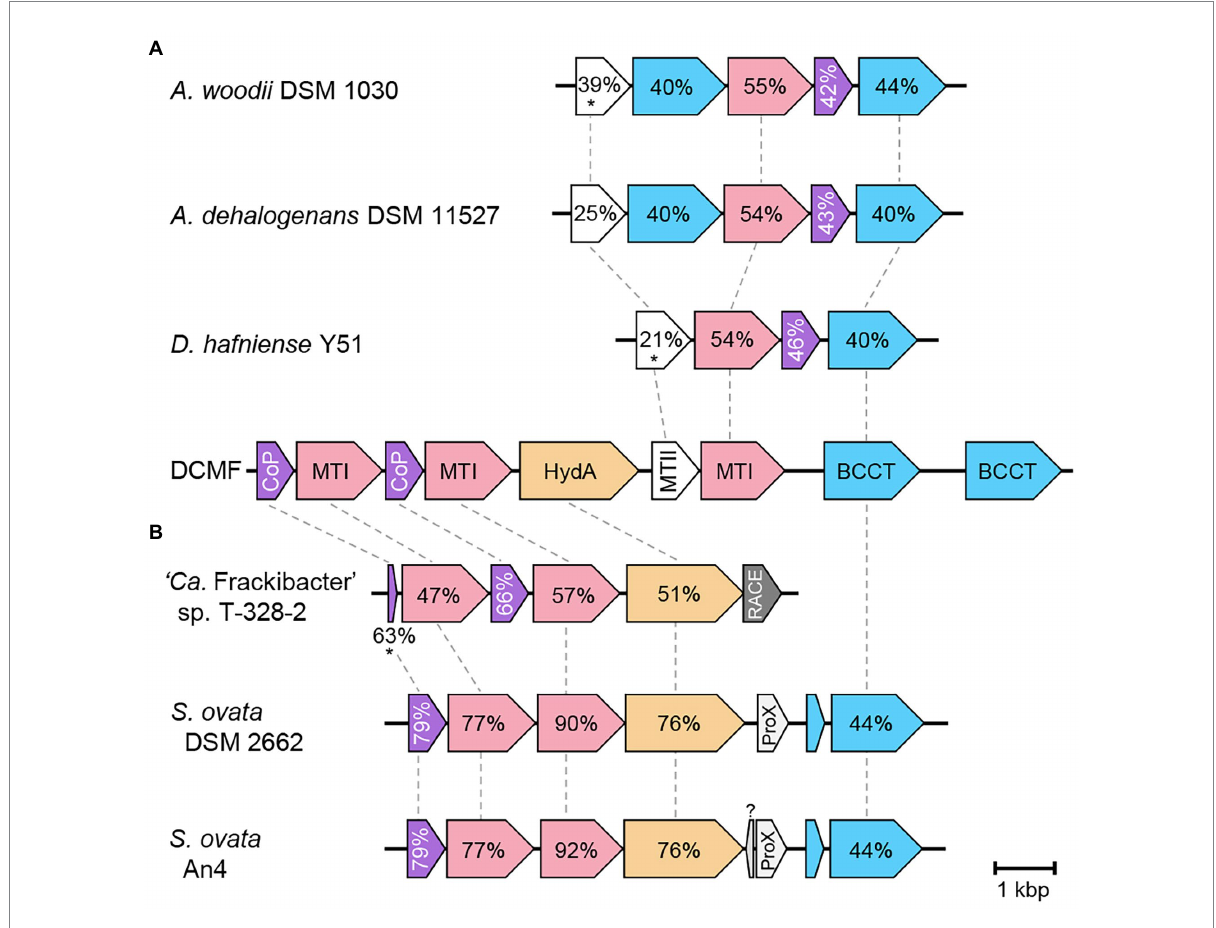
FIGURE 5 Genetic organization of the glycine betaine methyltransferase gene cluster in strain DCMF and homologs in other glycine betaine-fermenting bacteria. Homologous clusters fell into two distinct groups, with similarity to the second (A) or first (B) half of the strain DCMF gene cluster. Homologous proteins are linked by dotted lines and percentage amino acid sequence identity to strain DCMF written within. Values in the unlinked BCCT and CoP proteins in Panel A are to the strain DCMF homolog with the highest percentage amino acid sequence identity: Ga0180325_114741 or Ga0180325_114736, respectively, in all cases). Loci shown are: Acetobacterium woodii DSM 1030 Awo_c07520 – Awo_07560, Acetobacterium dehalogenans DSM 11527 A3KSDRAFT_02713 – A3KSDRAFT_02709, D. hafniense Y51 DSY3157 – DSY3154, strain DCMF Ga0180325_114734 – Ga0180325_114742, ‘ Ca. Frackibacter sp.’ T328-2 AWU54_1980 – AWU54_1975, Sporomusa ovata DSM 2662 SOV_3c09370—SOV_3c09310, S. ovata An4 SpAn4DRAFT_2140 – SpAn4DRAFT_2133. CoP, corrinoid protein; MTI, methyltransferase I; HydA, hydantoinase; MTII, methyltransferase II; BCCT, betaine/carnitine/choline family transporter; RACE, reductive activator of corrinoid-dependent enzymes; ProX, extracellular glycine betaine ligand binding protein. Asterisks indicate proteins with <30% query coverage of the strain DCMF